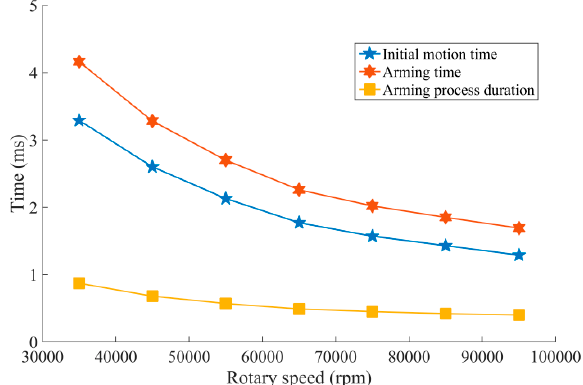
Figure 8. The fitting curves of arming-related time from simulation results.